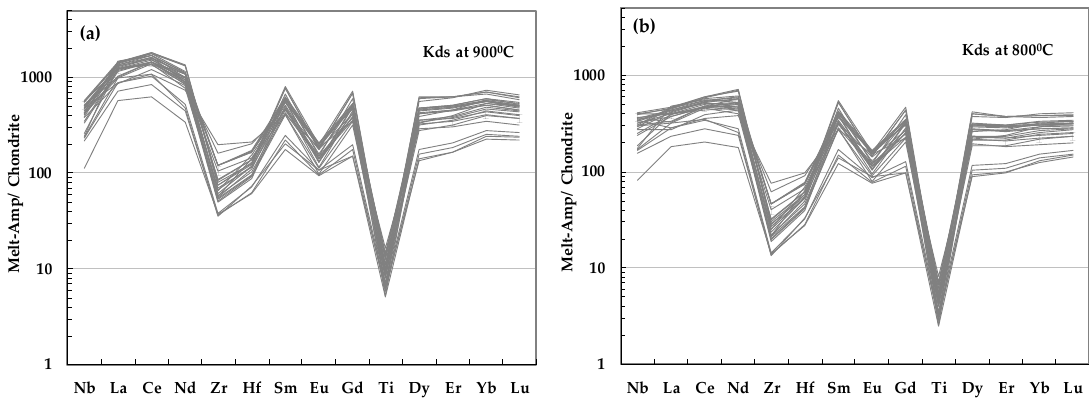
Figure 20. Reconstructed felsic melts pattern in equilibrium with brown amphibole in veins; amphibole-melt partition coefficients (Kds) from Klein et al. in Reference [46]. ( a ) Kds at 900 °C, ( b ) Kds at 800 °C. Unpublished data from Du Khac Nguyen during Ph.D. course of study at Kanazawa University.